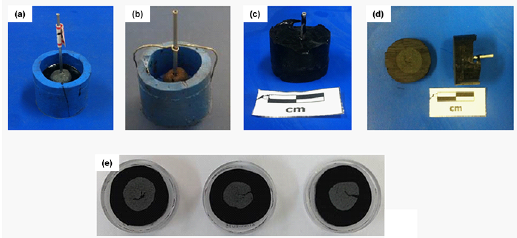
Figure 3. Sample preparation for OM: (a) mounted in resin; (b) fixed by a support so that the pellet does not move; (c) sample ready for surface preparation; (d) cutting and polishing of the sample; (e) Polished